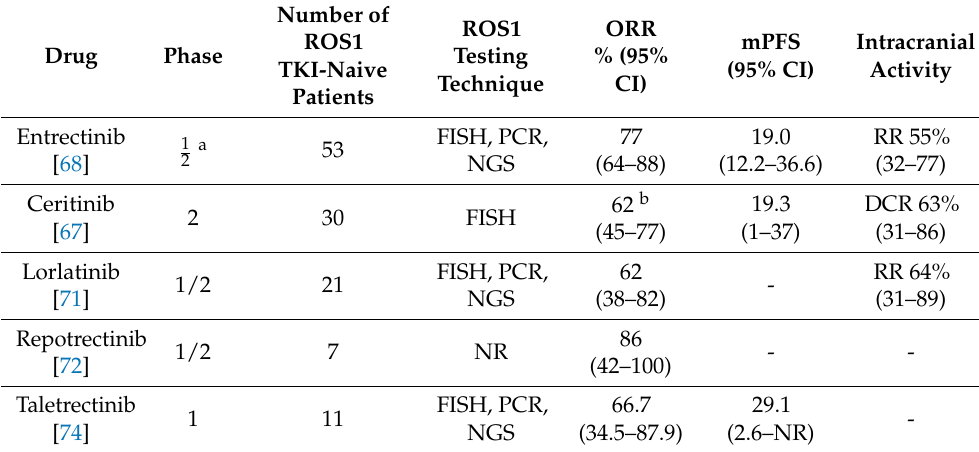
Table 3. Main clinical trials about next generation TKIs as first-line treatment.